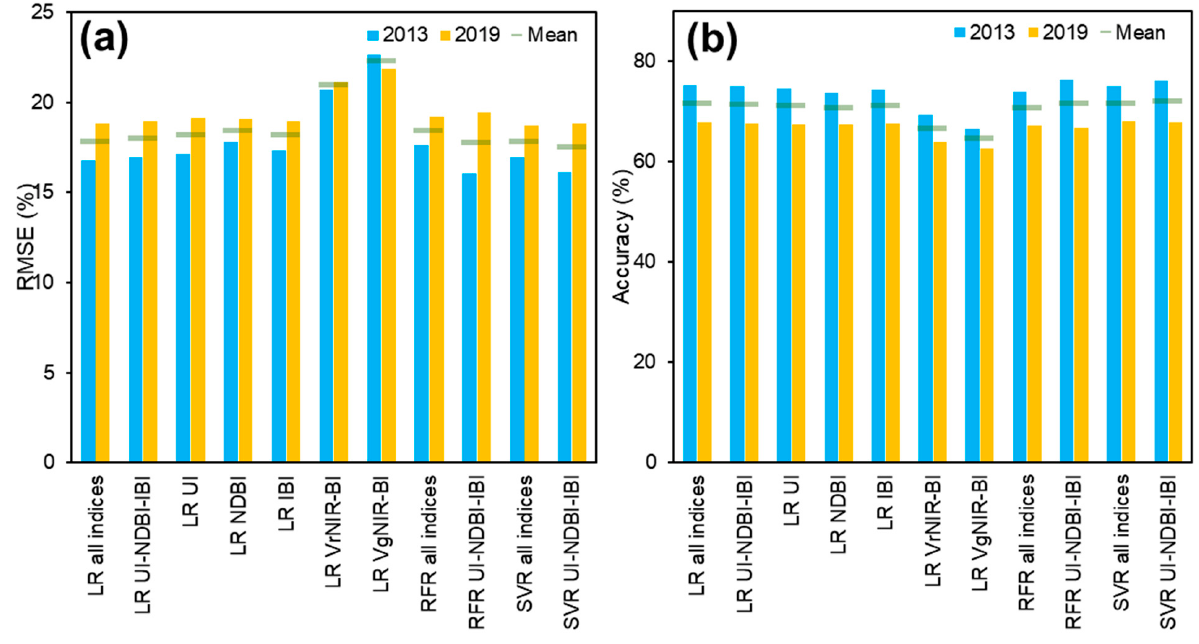
Figure 6. ( a ) RMSE and ( b ) upper range of accuracy at 95% confidence level for each building density estimation using linear regression (LR), random forest regression (RFR), and support vector regression (SVR), tested on the datasets of 2013 and 2019.